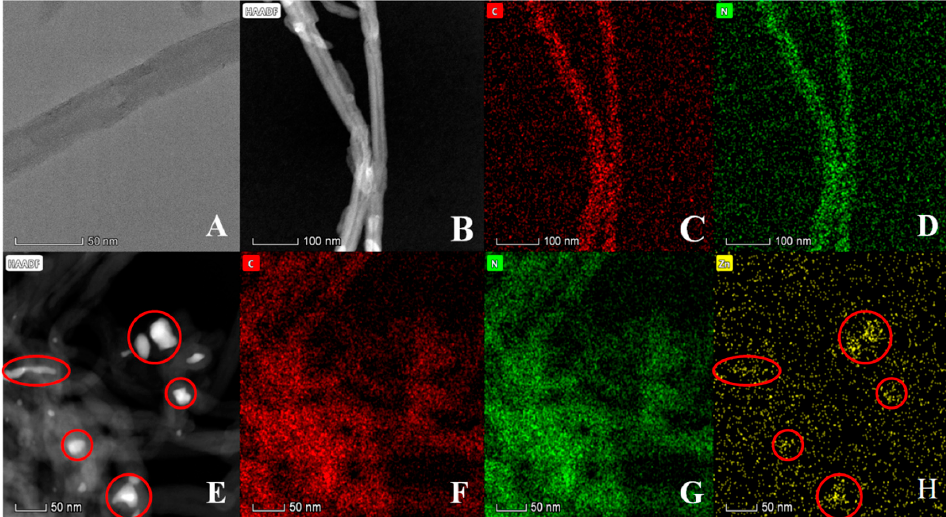
Figure 2. ( A ) TEM image of MWCNTs; ( B , E ) HAADF images of Zn–PPIX–CS–MWCNTs; ( C , D , F , G , H ) map-scan image of Zn–PPIX–CS–MWCNTs.